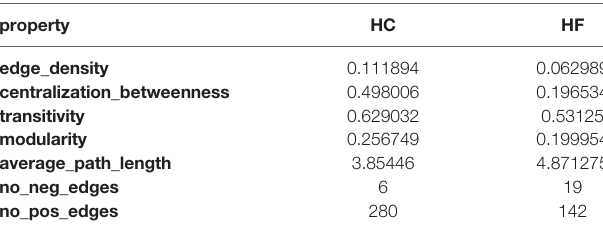
TABLE 3 | Properties of